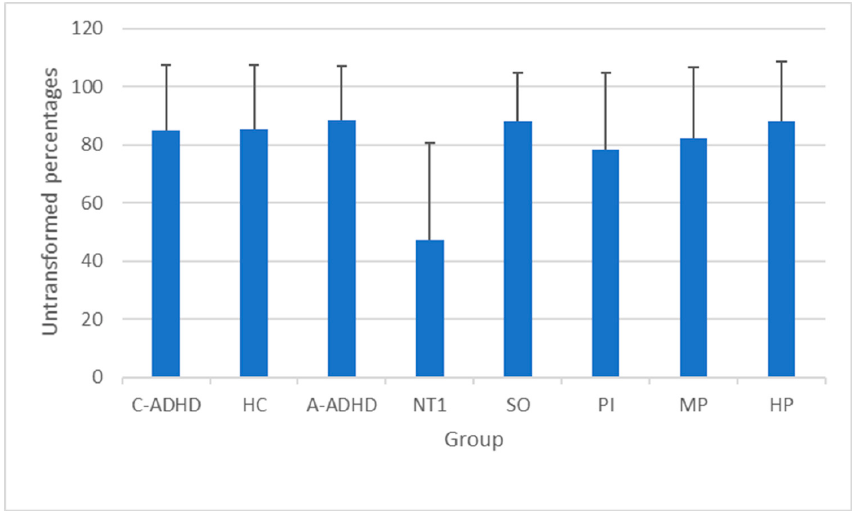
Figure 1. Means and standard deviations of prospective memory performance at get-up time in each group. In order to present the results more clearly, we have chosen to report the untransformed percentages in the figure, even though the statistical analyses were performed on the percentages subjected to arcsine transformation. C-ADHD = childhood attention deficit hyperactivity disorder; HC = healthy controls; A-ADHD = adult attention deficit hyperactivity disorder; NT1 = narcolepsy type 1; SO = severe obesity; PI = primary insomnia; MP = menopause; HP = essential hypertension.